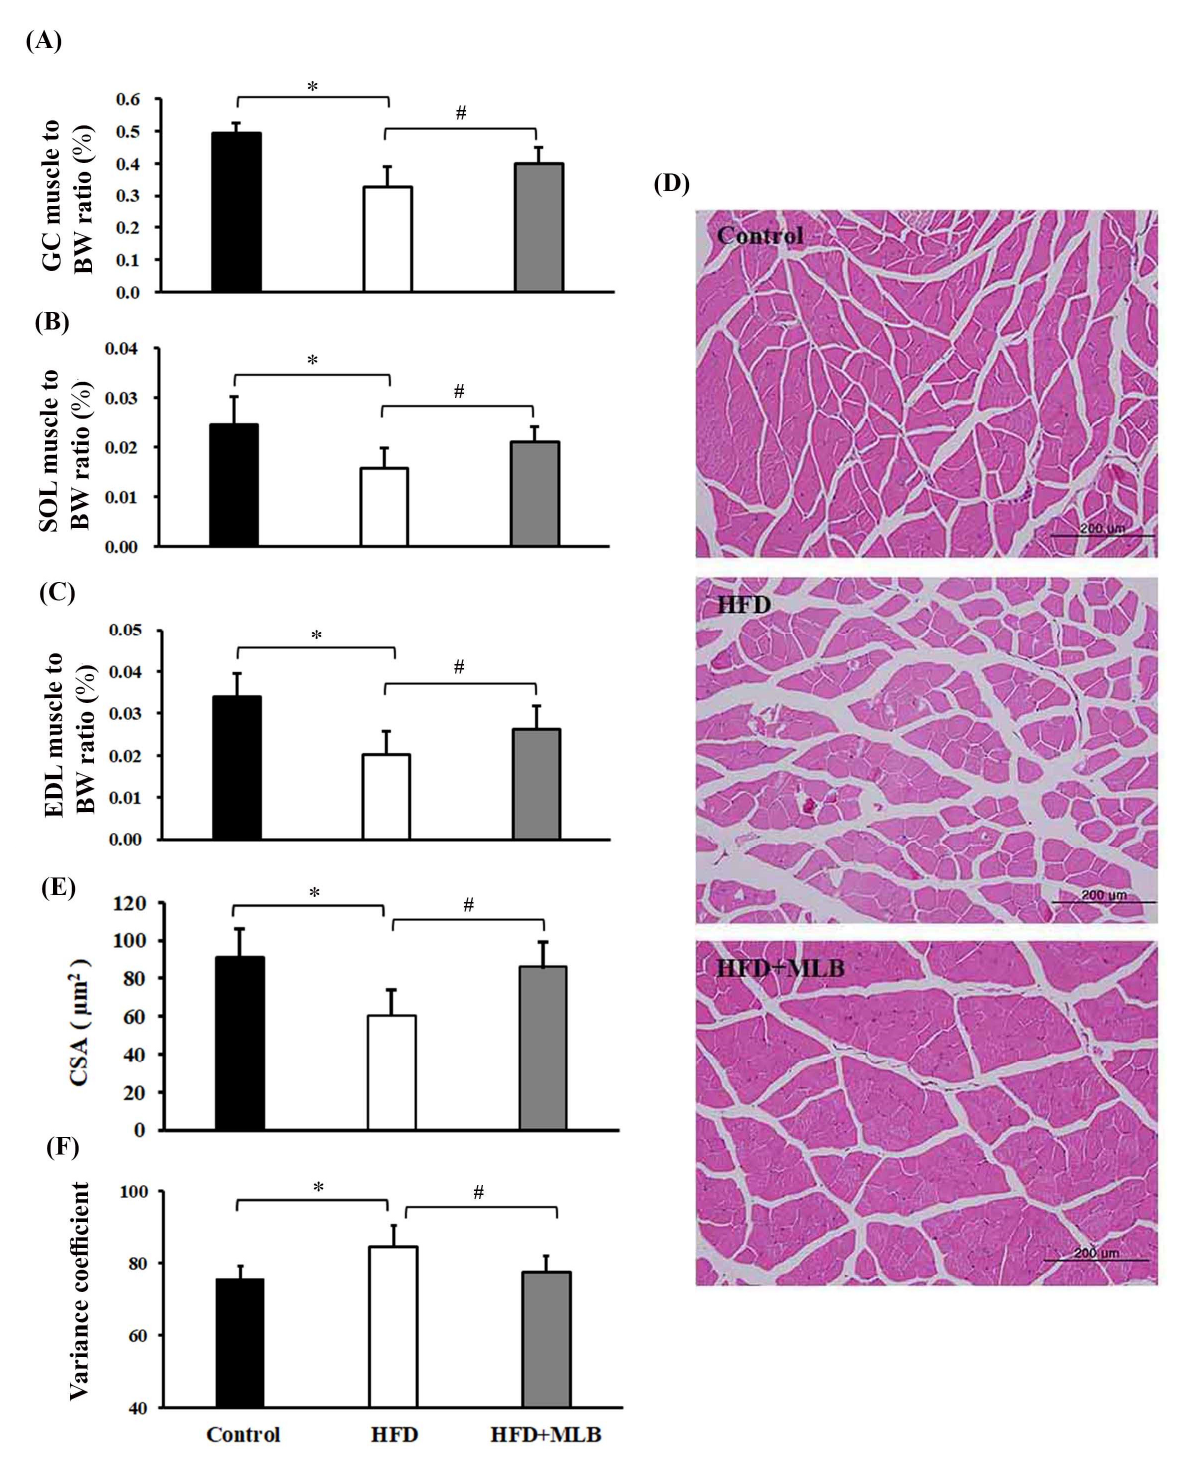
Figure 4. MLB supplementation attenuated HFD-induced muscle atrophy. At the end of the experiment, the skeletal muscles, namely the gastrocnemius (GC), extensor digitorum longus (EDL), and soleus (SOL) muscles, were removed and weighed. The ratios of the weight of the GC, SOL, and EDL muscles to the body weight are depicted ( A – C ). The representative hematoxylin and eosin (H&E) staining of GC muscles from each group are presented ( D ), and the relative muscle cross-sectional area (CSA) data are illustrated ( E ). Measurement of variance coefficients of the fiber size in the cross-sectional samples of three groups using Feret’s diameter as the geometrical parameter ( F ). Values are expressed as the mean ± SD. * p < 0.05 vs. control group. # p < 0.05 vs. HFD group. n = 8.